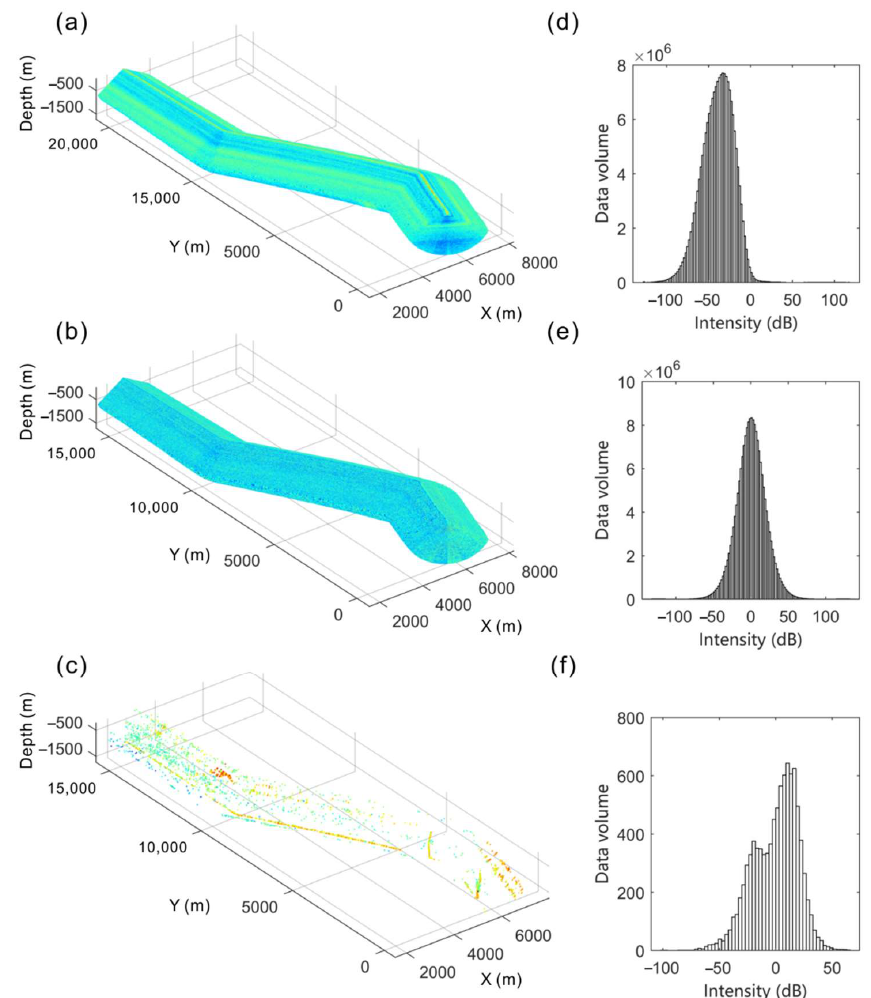
Figure 6. Comparison of the histogram results of the MWC point cloud and sampling point scattering intensity before and after calculation. ( a ) The point cloud image after spatial homing after raw MWC data resolution, where the point cloud is attached with the scattering intensity, and a lot of MWC noise with high scattering intensity values is found in MWC; ( b ) An MWC point cloud image after symmetric subtraction, where the noise is restored to normal in large; ( c ) The image with the background point cloud removed by Otsu algorithm, where the plume target in the MWC is exposed, and there is still a small amount of unregulated noise in MWC; ( d ) A histogram of the scattering intensity of the raw MWC data, where the amount of data at the water sampling points is huge, and the reflected intensity values at the sampling points have a negatively skewed distribution; ( e ) A histogram of the scattering intensity of the MWC data after symmetric subtraction, where the scattering intensity of the sampling points has a standard normal distribution, and the amount of data at the sampling points with high scattering intensity decreases while the peak increases; ( f ) A histogram of the scattering intensity of the MWC data after the Otsu algorithm, where the data at the sampling points is significantly reduced, and the reflection intensity values at the sampling points have a double-peaked structure.